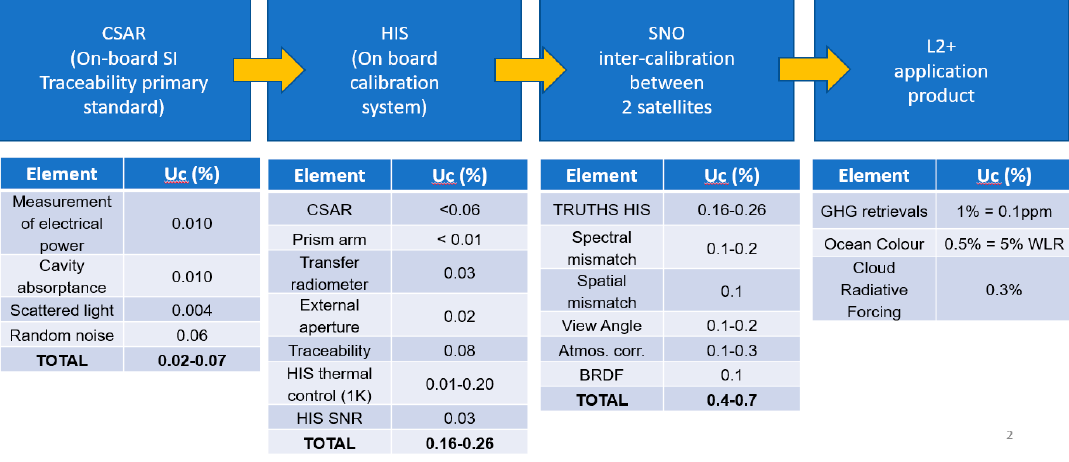
Figure 15. Uncertainty (k = 2) propagation to inter-calibration and L2+ products.